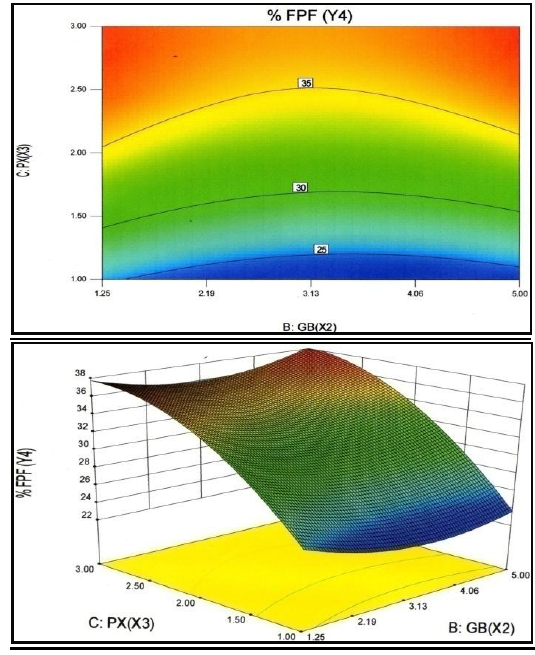
Figure 8: Response surface contour plot (Up) and 3D plot (down) for GB and PX effect on